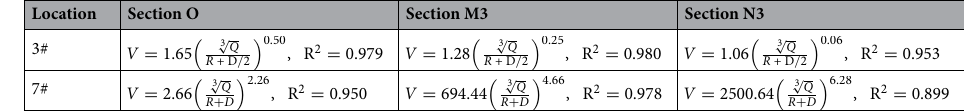
Table 3. PPV fitting formula of measuring points 3# and 7# at different tunnel spans.